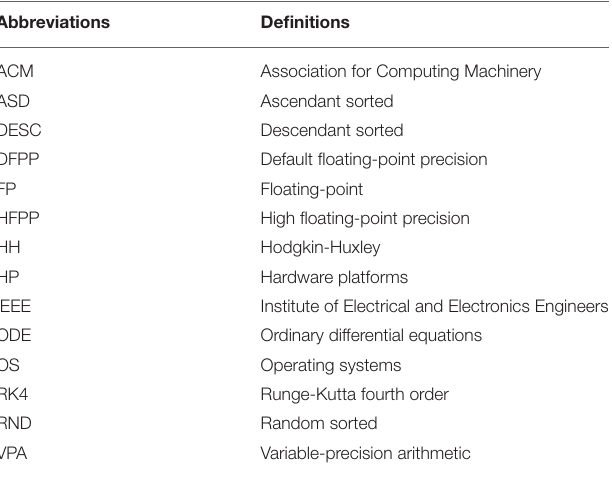
( Figure 1 ), with special attention to the Iapp vector order cases (Random, Ascendent, and Descendant) ( Figure 1 , rows), and constituting an aspect that was not explored in Blanco et al.